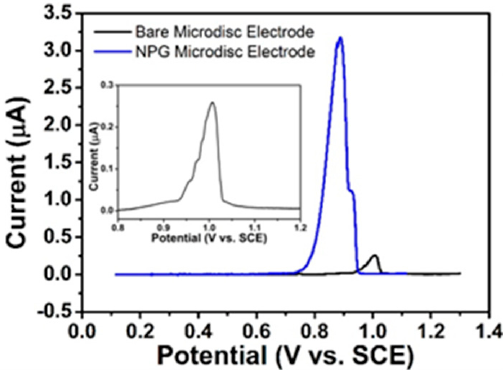
Figure 7. LSVs at bare gold (black)- and NPG-modified microdisc array (blue) electrode arrays vs. SCE at 10 mV s − 1 in 0.0154 M NaCl and 0.05 mM H 2 SO 4 background solution (inset shows the response at bare gold microdisc array).